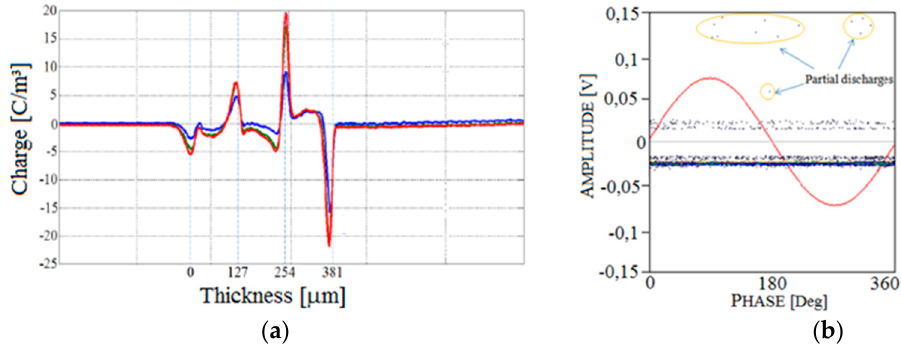
Figure 20. Simultaneous pattern acquisition of ( a ) the space charge and ( b ) the partial discharges. The red line is the AC reference voltage that is displayed permanently.